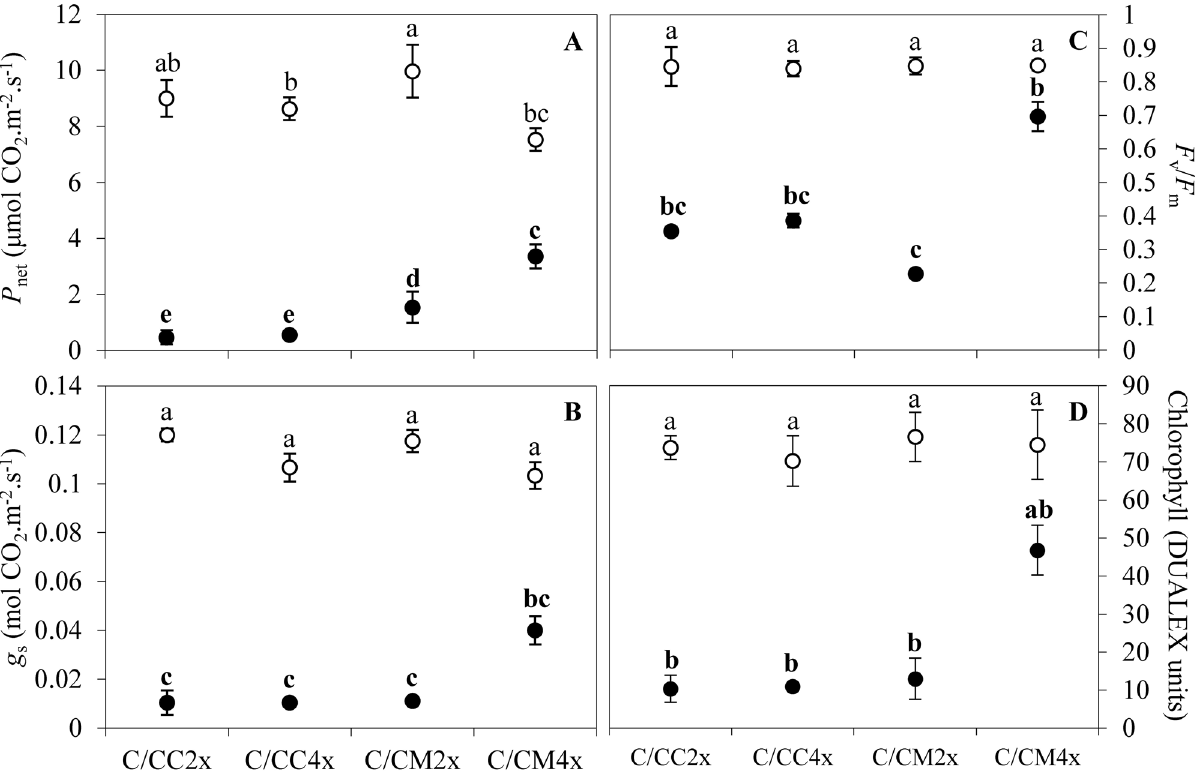
Figure 2. Effect of nutrient deficiency on photosynthetic properties of leaves of common clementine scion grafted onto different rootstocks. ( A ) Leaf net photosynthetic rate ( P net ), ( B ) stomatal conductance ( g s ), ( C ) chlorophyll fluorescence ( F v / F m ) and ( D ) chlorophyll contents of leaves of common clementine scion grafted onto diploid (C/CC2x) and doubled diploid (C/CC4x) Carrizo citrange and diploid (C/CM2x) and doubled diploid (C/CM4x) Citrumelo 4475 rootstocks grown in nutrient reference solution (100%) (white circles) and without nutrient solution (0%) (black circles) for 210 days. Values are mean (± standard error) of 9 independent measurements ( n = 9) for each scion/rootstock combination, i.e. three per tree. Ploidy and treatment effects were analyzed using ANOVA and Fisher LSD tests ( p < 0.05). Distinct letters indicate significant differences between all scion/rootstocks combinations and treatments.